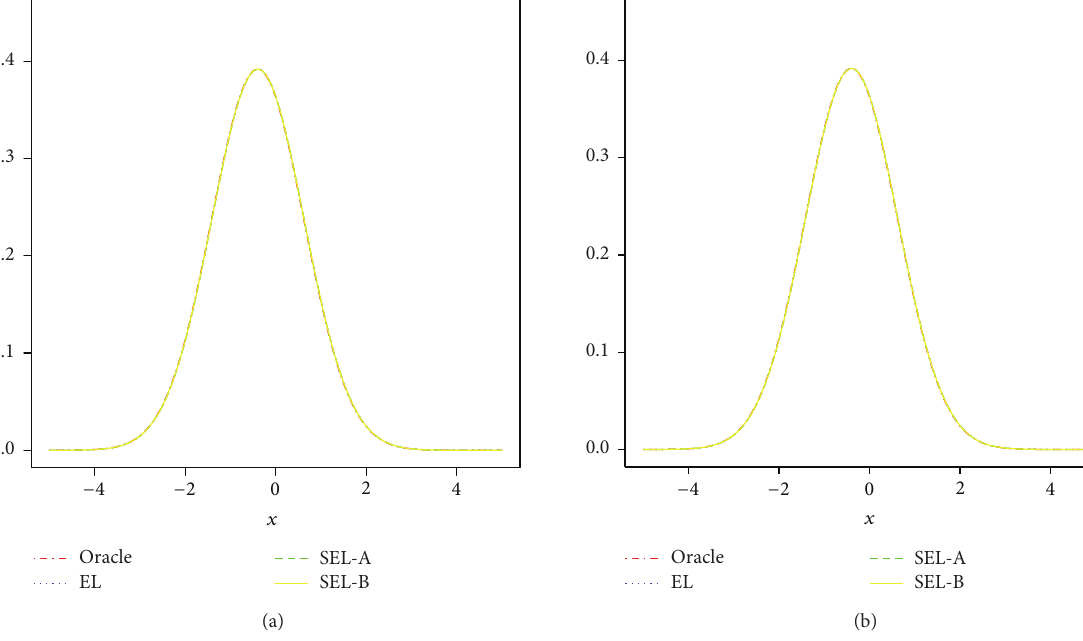
Figure 2: Finite sample densities of EL and EL shrinkage estimators for 𝜃 1,0 in the cases of example (1). The SCAD penalty is used in the EL shrinkage estimation and the first-step estimators of moment selection coefficients are the EL estimators; (2) oracle estimators are the EL estimators using the moment conditions in set-1 and all correct moment conditions in set-2; (3) EL estimators only use the moment conditions in set-1; (4) SEL-A refers to the EL shrinkage estimators using tuning parameters selected by minimizing EmAIC; (5) SEL-B refers to the EL shrinkage estimators using tuning parameters selected by minimizing